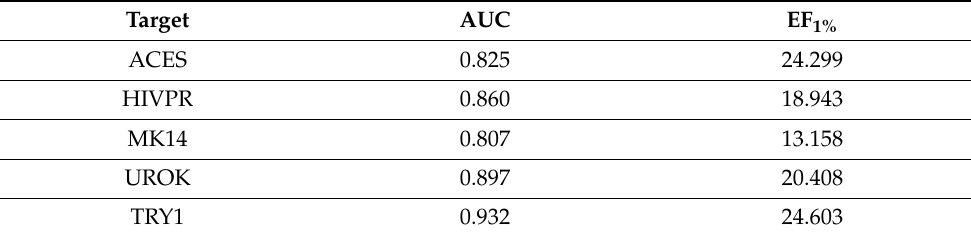
Table 3. Test set AUC and EF 1% values obtained for 3-descriptors EOA